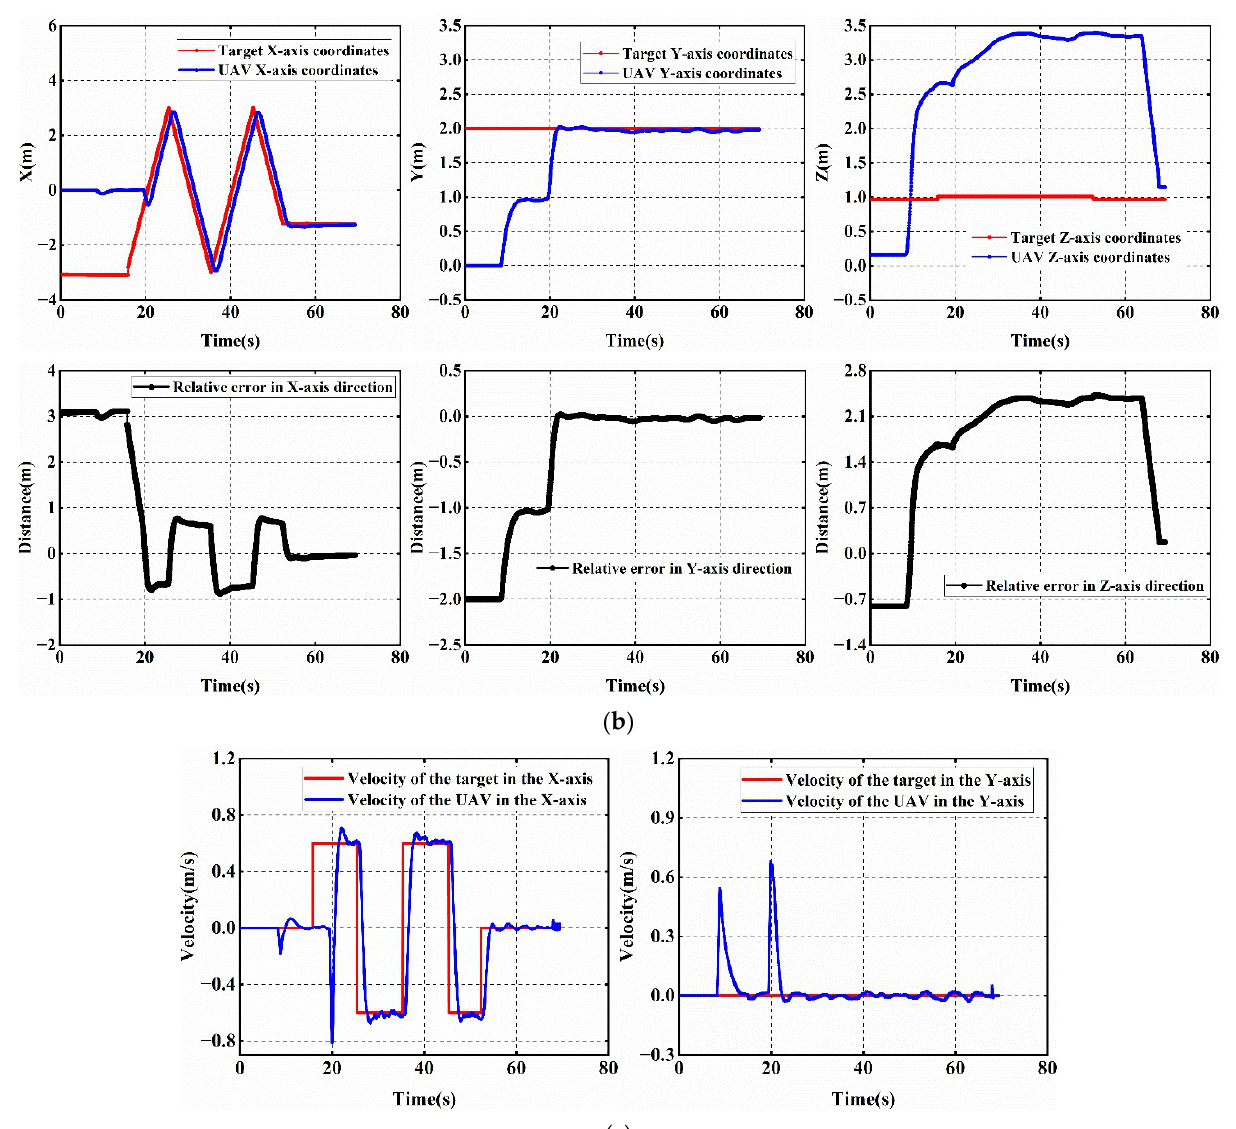
Figure 13. ( a ) 3D trajectory of drone and target; ( b ) tracking results and errors; and ( c ) speed comparison between drone and target.